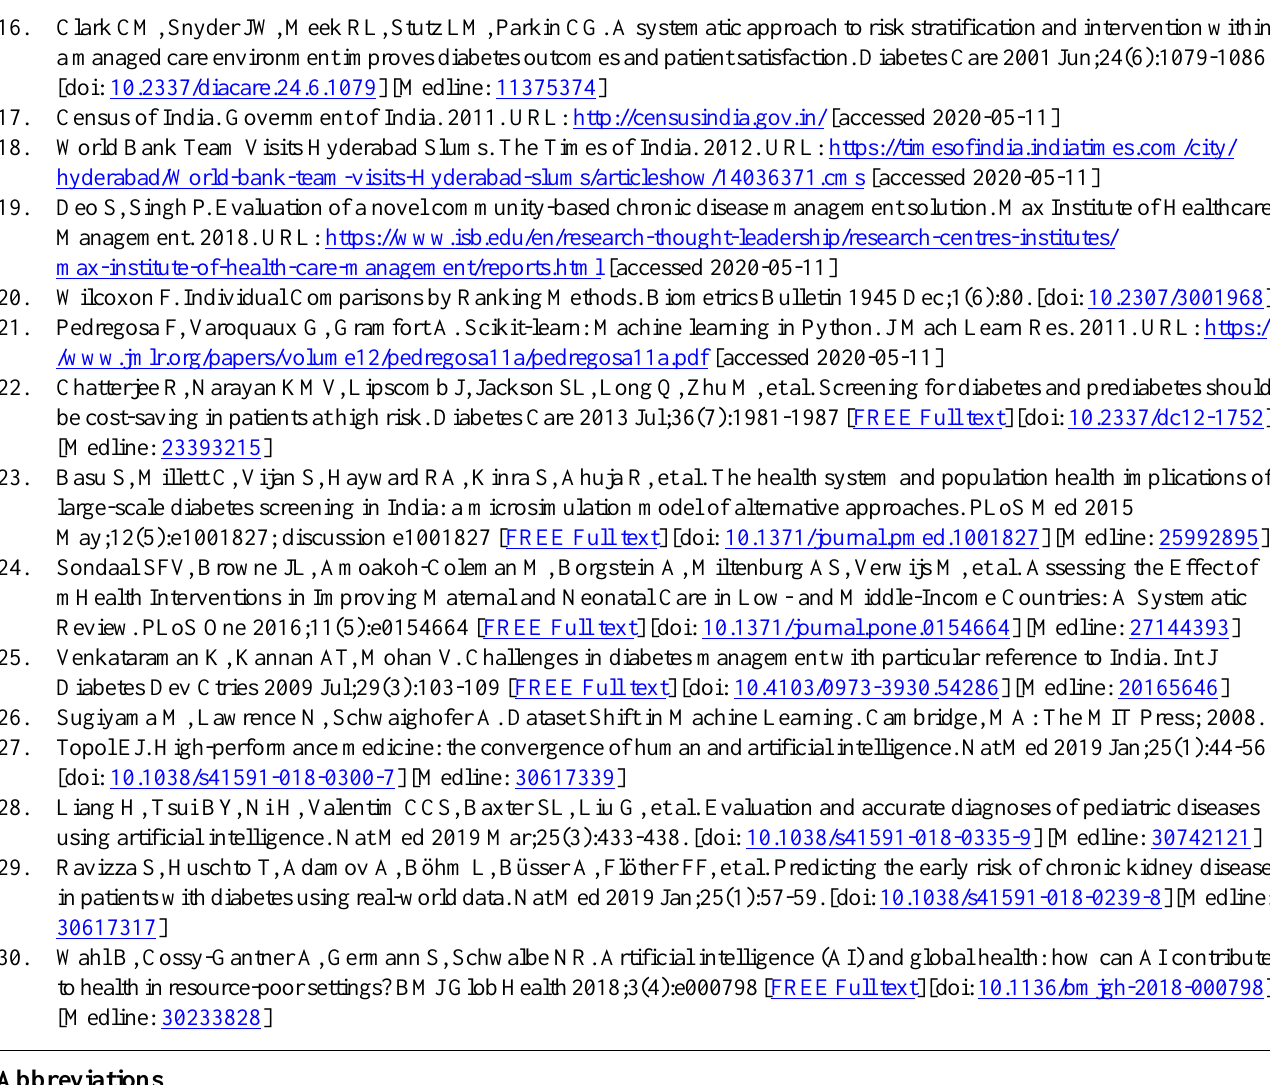
AUC: area under the receiver operating characteristic curve HbA : glycated 1c